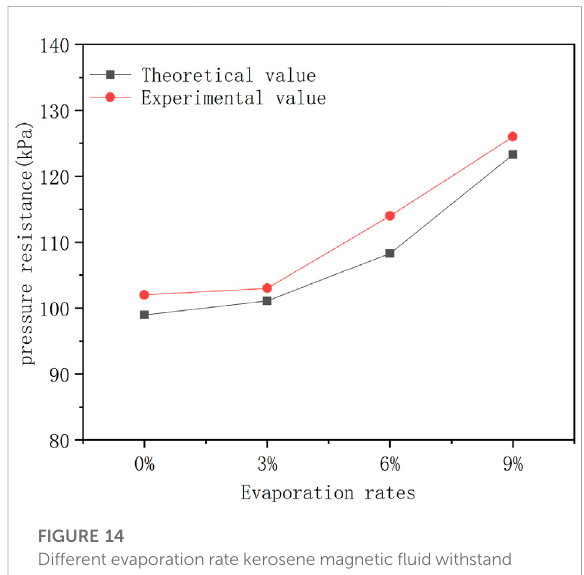
FIGURE 14 Different evaporation rate kerosene magnetic fl uid withstand